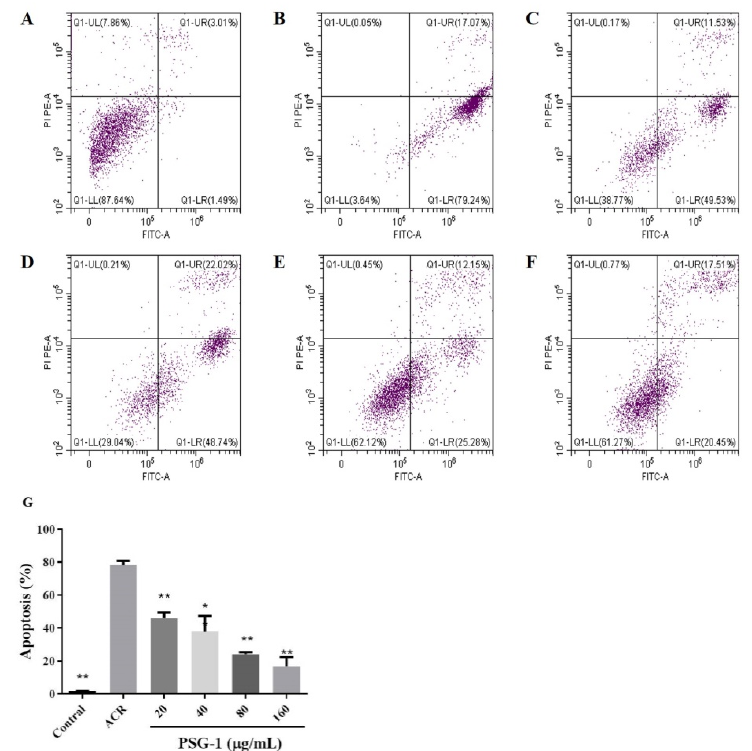
Figure 5. PSG-1 attenuated acrolein-induced apoptosis. Apoptosis measured by flow cytometry. ( A ) control cells; ( B ) the cells treated with acrolein, ( C – F ) the cells treated with acrolein and PSG-1 at concentrations of 20, 40, 80and 160 μ g/mL, ( G ) Effect of PSG-1 on acrolein-induced apoptosis. Values are means ± SD ( n = 3), * p < 0.05, ** p < 0.01 compared with the acrolein group.